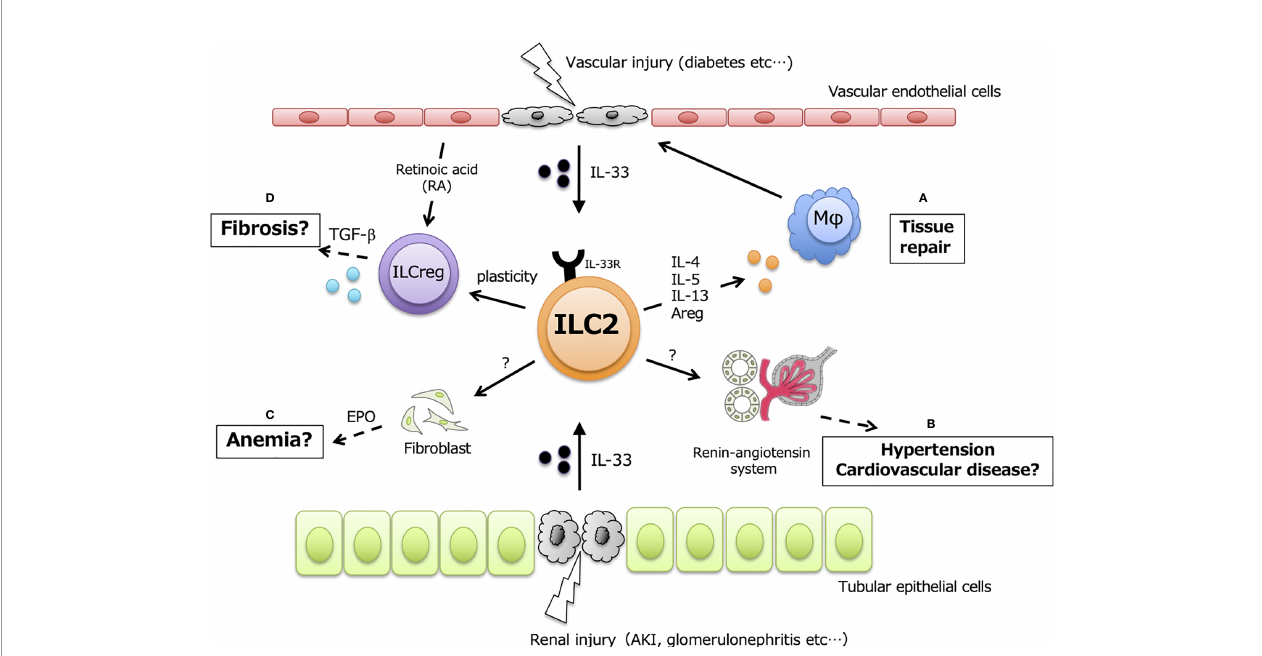
FIGURE 1 | Potential functions in renal ILC2. ILC2 have protective functions in kidney, but exerts positively or negatively effects in dependent on the amount of renal IL-33. Upon kidney injury and disease, IL-33 released from vascular endothelial cells and/or tubular epithelial cells leads to activate renal-resident ILC2, and secreted type2 cytokines possibly affects in following events; (A) tissue repair by inducing M2 macrophages, (B) hypertension and cardiovascular disease through renin- angiotensin system, (C) renal anemia mediated by EPO, (D) renal fi brosis via the plasticity for TGF- b producing